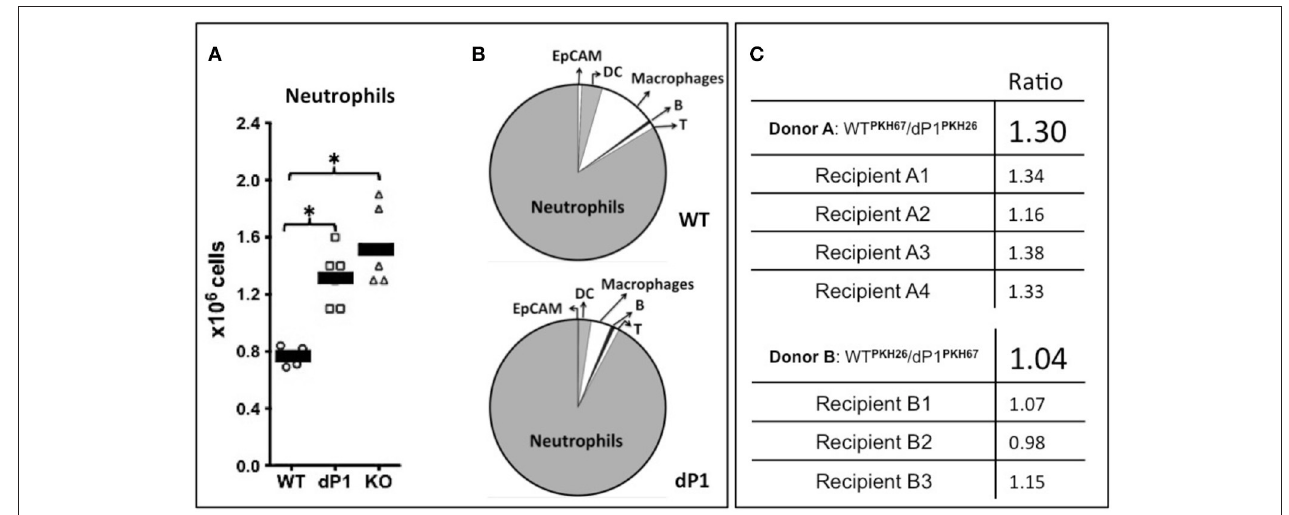
FIGURE 2 | More severe neutrophilic acute airway inflammation in animals with ST6Gal-1 deficiency. Wild type C57BL/6 (WT), ST6Gal1-dP1 (dP1), and ST6Gal1-KO (KO) mice were exposed to 10 6 CFU of live NTHI bacteria by oropharengeal instillation. Eighteen hours later, the bronchoalveolar lavage fluid (BALF) was collected, Leukocyte number was counted, and leukocyte composition was determined by flow cytometry. (A) shows the total numbers of neutrophils recovered from the BALF of NTHI-instilled animals, showing greater neutrophilic inflammation in dP1 and KO, compared to WT (1.6 and 2.0-fold, respectively). * p < 0.05 for indicated comparisons. (B) , top shows the cellular composition of WT BALF, consisting predominantly of neutrophils (83.5%). Macrophage (10.5%), dendritic cells (DC, 3.8%), T- (1%), and B- (0.5%) cells, with a minor constituent of epithelial cells as defined by EpCAM (0.7%). (B) , bottom, shows dP1 BALF composition, which was essentially identical to WT BALF in percentage cellular contribution from the assessed cell types. (C) Neutrophils from the marrows of WT and dP1 mice were isolated by negative selection. The cells were stained with one of the two distinct membrane dyes (red PKH-26 and green PKH-67), mixed in an ∼ 1:1 ratio and injected into 3–4 WT recipients 2h after NTHI challenge. In the top panel, the initial PKH67-labeled WT/ PKH26-labeled dP1 neutrophils ratio was 1.30. In the bottom panel, PKH26-WT/PKH67-dP1 neutrophil donor ratio was 1.04. At 18h, this neutrophil-fluorescence ratio was again measured in cells obtained from the BALF. No difference in airway recruitment was noted for dP1 neutrophils compared to WT